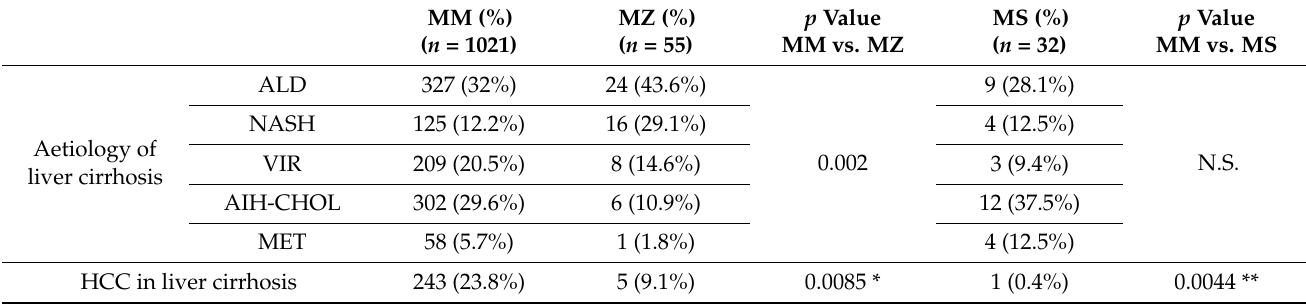
Table 3. Aetiology of liver cirrhosis and occurrence of HCC in liver cirrhosis according to the SERPINA1